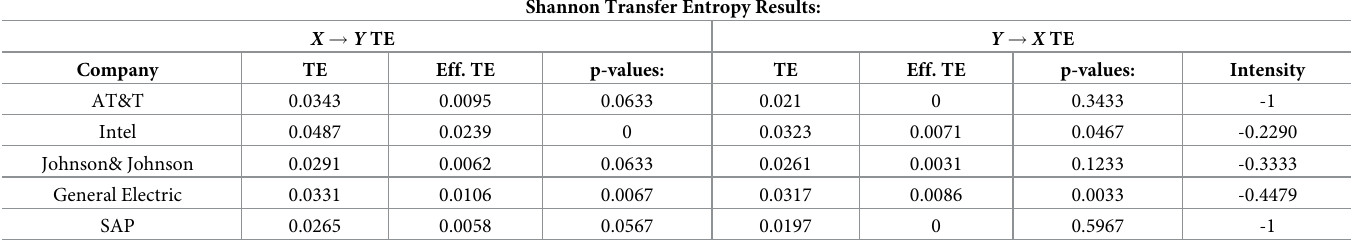
Table 3. Information flux from X ! Y TE.